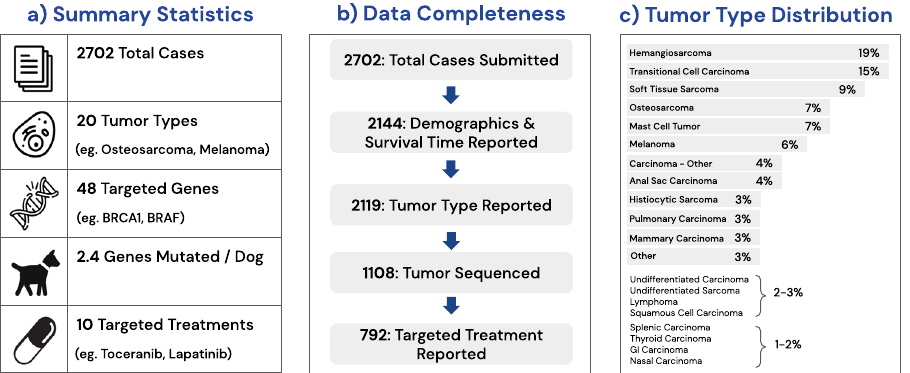
Fig. 1 Summary of the dataset used for analysis. a Counts of the unique number of cases, tumor types, targeted genes, mutations/dog, and targeted treatments. b The number of dogs with complete values for each feature reported. Completeness is reported cumulatively at each step. For example, the 2119 cases with complete tumor type reported also have complete demographics and survival times. c The distribution of tumor types in dogs, as a percentage of the 2119 dogs with tumor types, demographics, and survival outcomes reported.